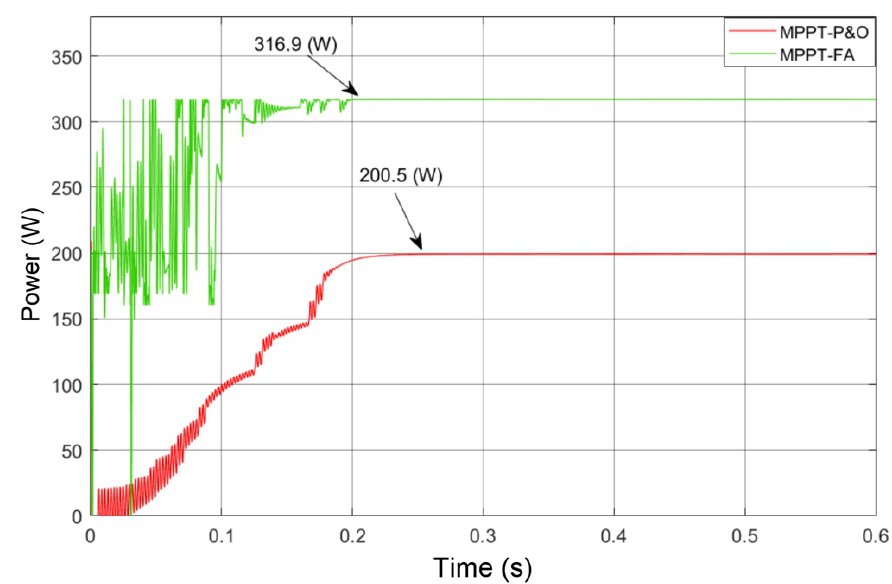
Figure 14. Simulation Results Step 2: Output Power P&O (200.5 W), Output Power FA (316.9 W).